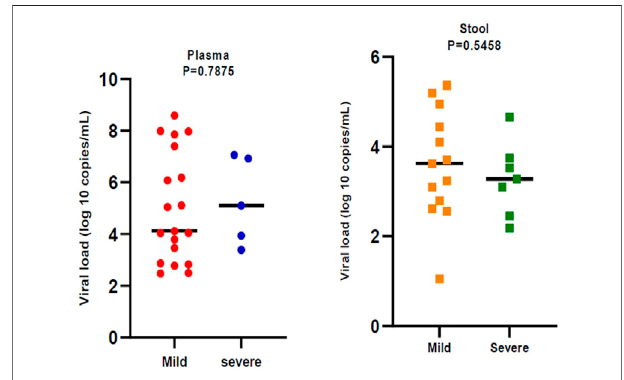
FIGURE 2 | Comparison of severe acute respiratory syndrome coronavirus 2 (SARS -CoV-2) viral load by disease severity. Black bars represent